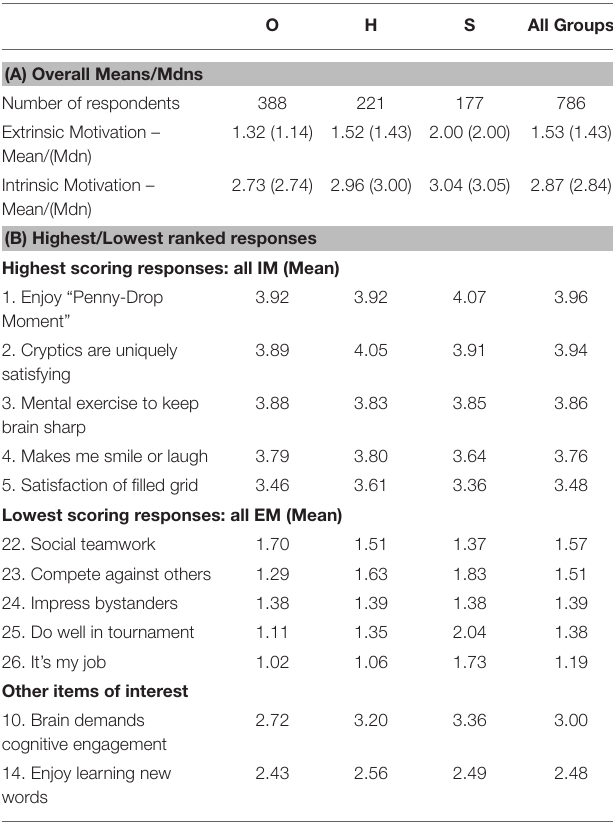
TABLE 11 | RIASEC analysis of hobby primary codes by expertise group. TABLE 12 | Intrinsic/Extrinsic crossword solving